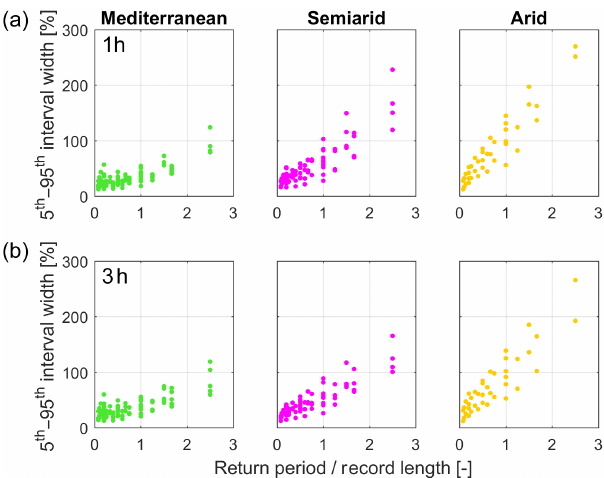
Figure 10. Relative uncertainty (width of the 5–95th quantile inter- val of the 999 bootstrap sampling repetitions normalized over the rain gauge-IDF value) plotted against the ratio between the esti- mated return period and the record length. The first row of panels shows the results for 1h duration, the second row for 3h. Columns of panels show results for each climatic